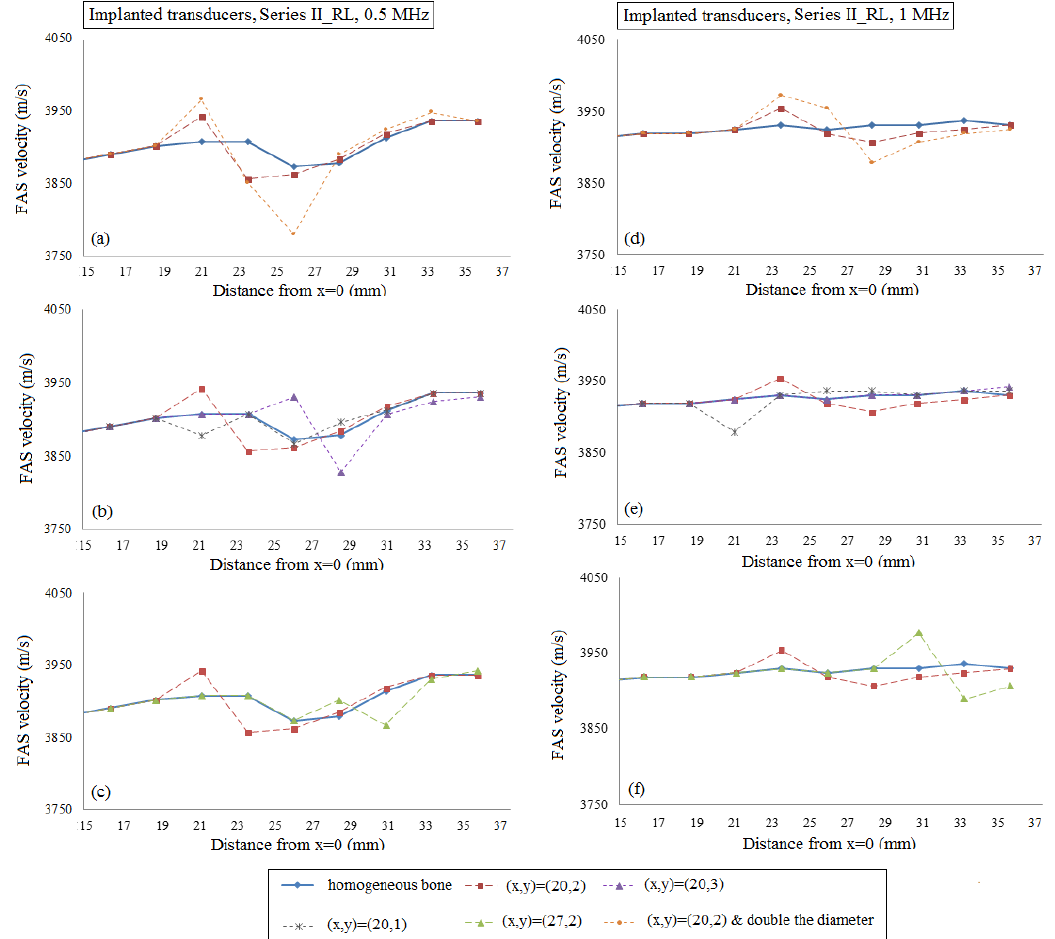
Figure 9. The potential of the local FAS velocity to detect the occurrence of a single RL considering cortical bone as a homogeneous medium (geometries illustrated in Figure 3a–e). The diagrams correspond to the second set of simulations under the assumption of implanted transducers and the excitation frequencies: ( a )–( c ) 0.5 MHz; and ( d )–( f ) 1 MHz. The legend describes the center coordinates of the RL.